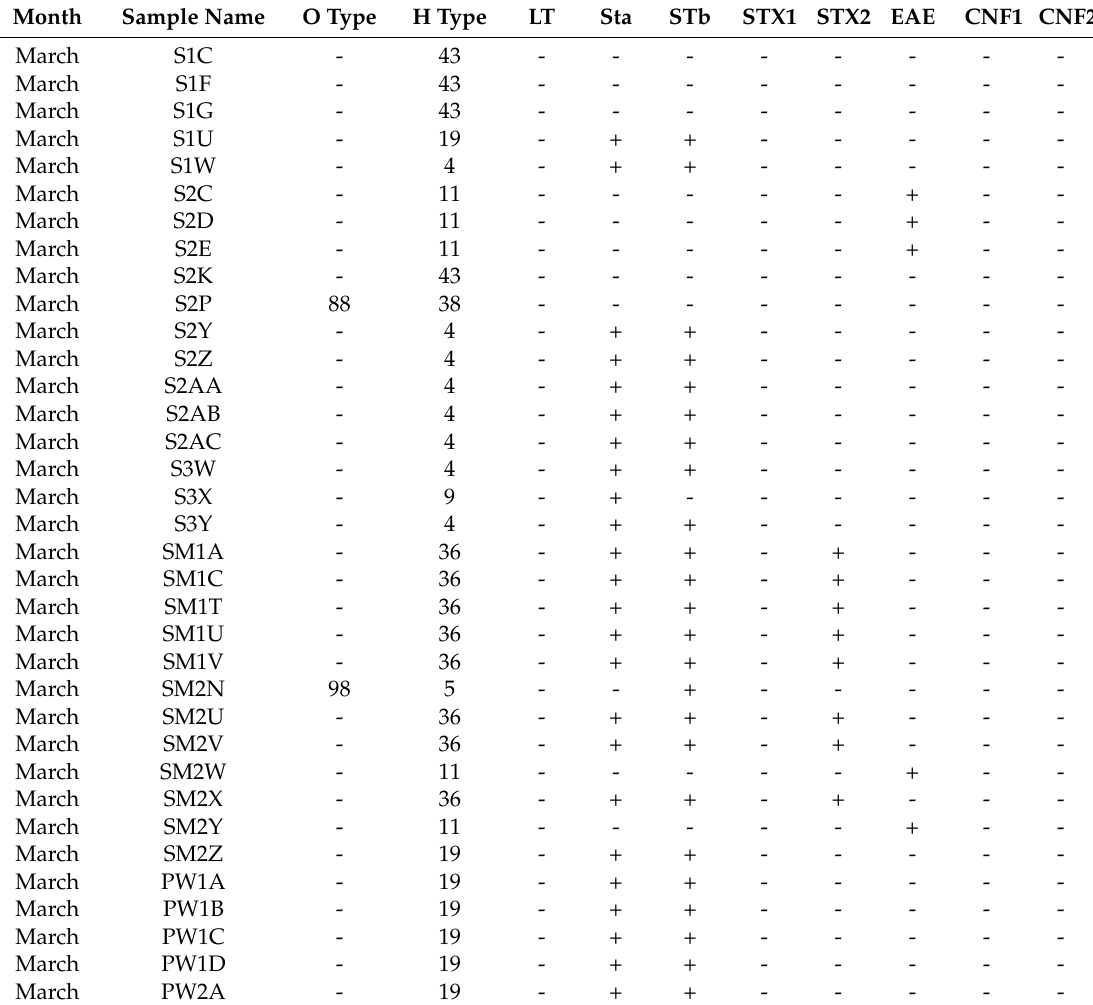
Table 1. Virulence gene and resistant genotypes of potential pathogenic E. coli from swine constructed